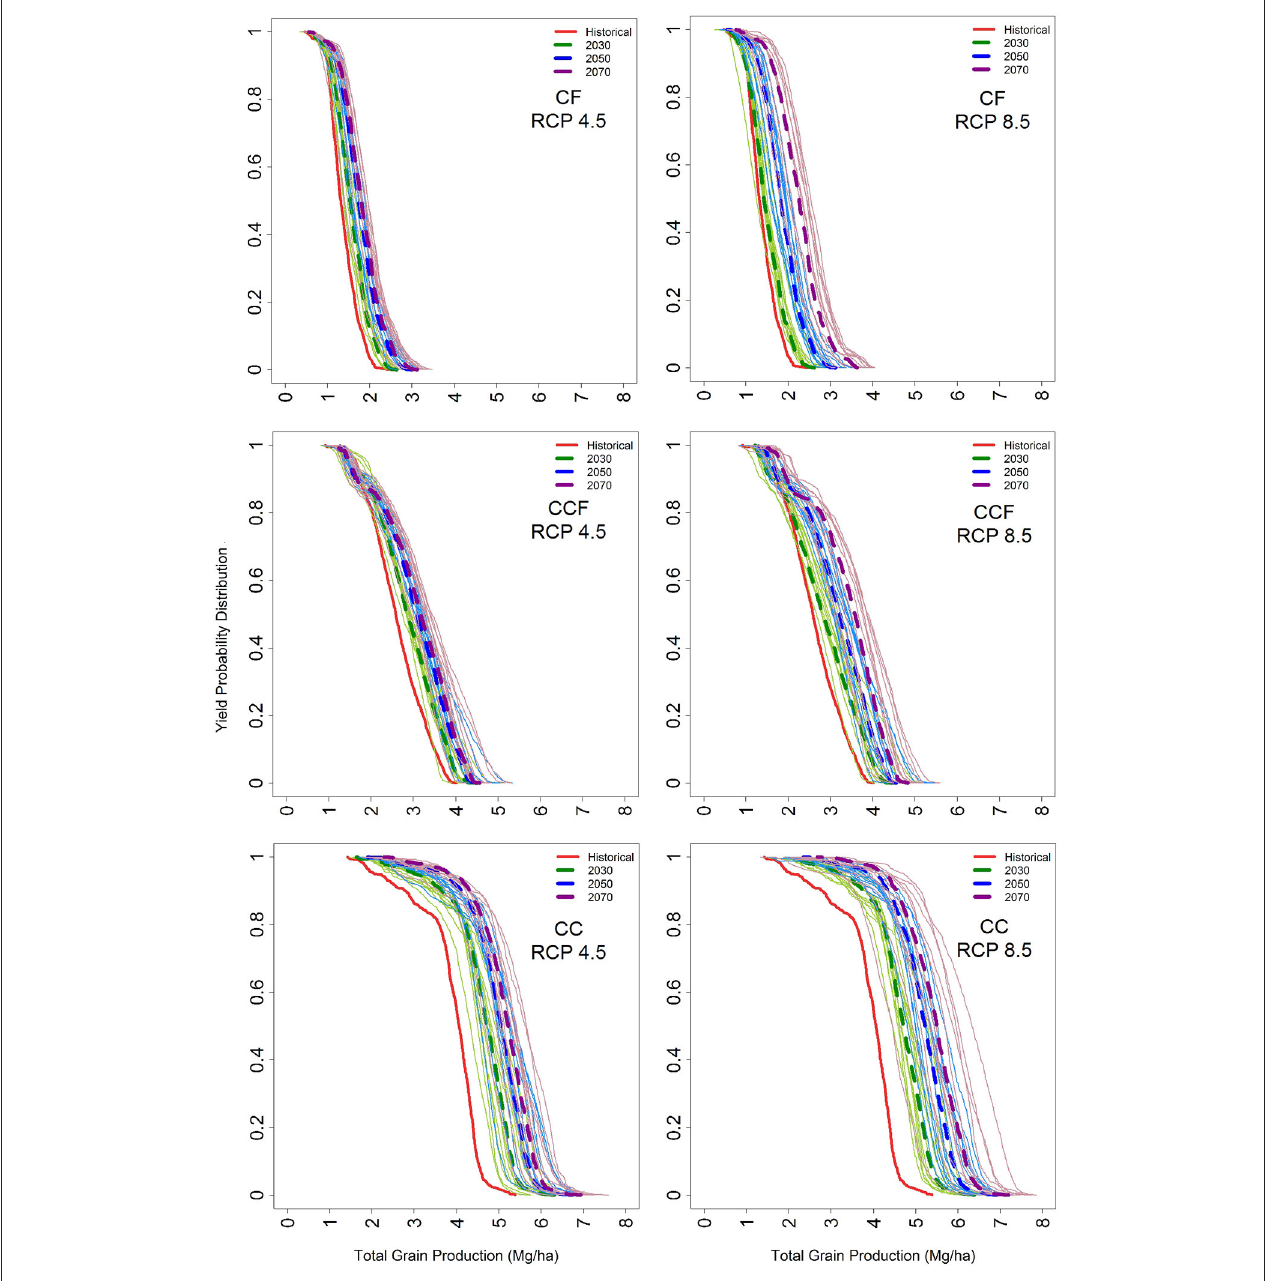
FIGURE 2 | Yield probability distribution for grid cells in crop/fallow (CF), annual crop/fallow transition (CCF) and continuous cropping (CC) agroecological classes of the Inland Pacific Northwest for historical and future periods under 2 representative concentration pathways (RCP), 4.5 and